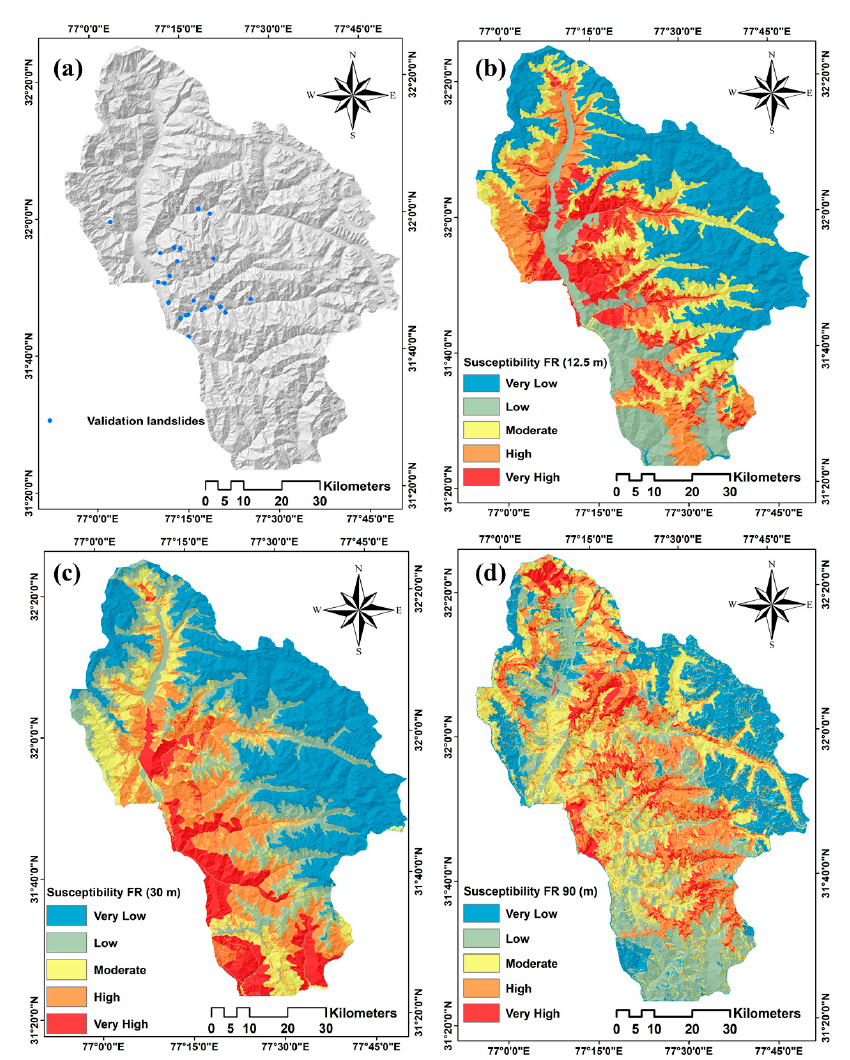
Figure 5. Landslide susceptibility maps resulting from the FR model based on three different resolution DEMs: ( a ) Landslide validation points used for accuracy assessment ( b ) Advanced Land Observing Satellite-1 (ALOS) Phased Array type L-band Synthetic Aperture Radar (PALSAR) (ALOS-PALSAR) 12.5 m, ( c ) Advanced Spaceborne Thermal Emission and Reflection Radiometer (ASTER)-Global 30 m and ( d ) Shuttle Radar Topography Mission (SRTM) 90